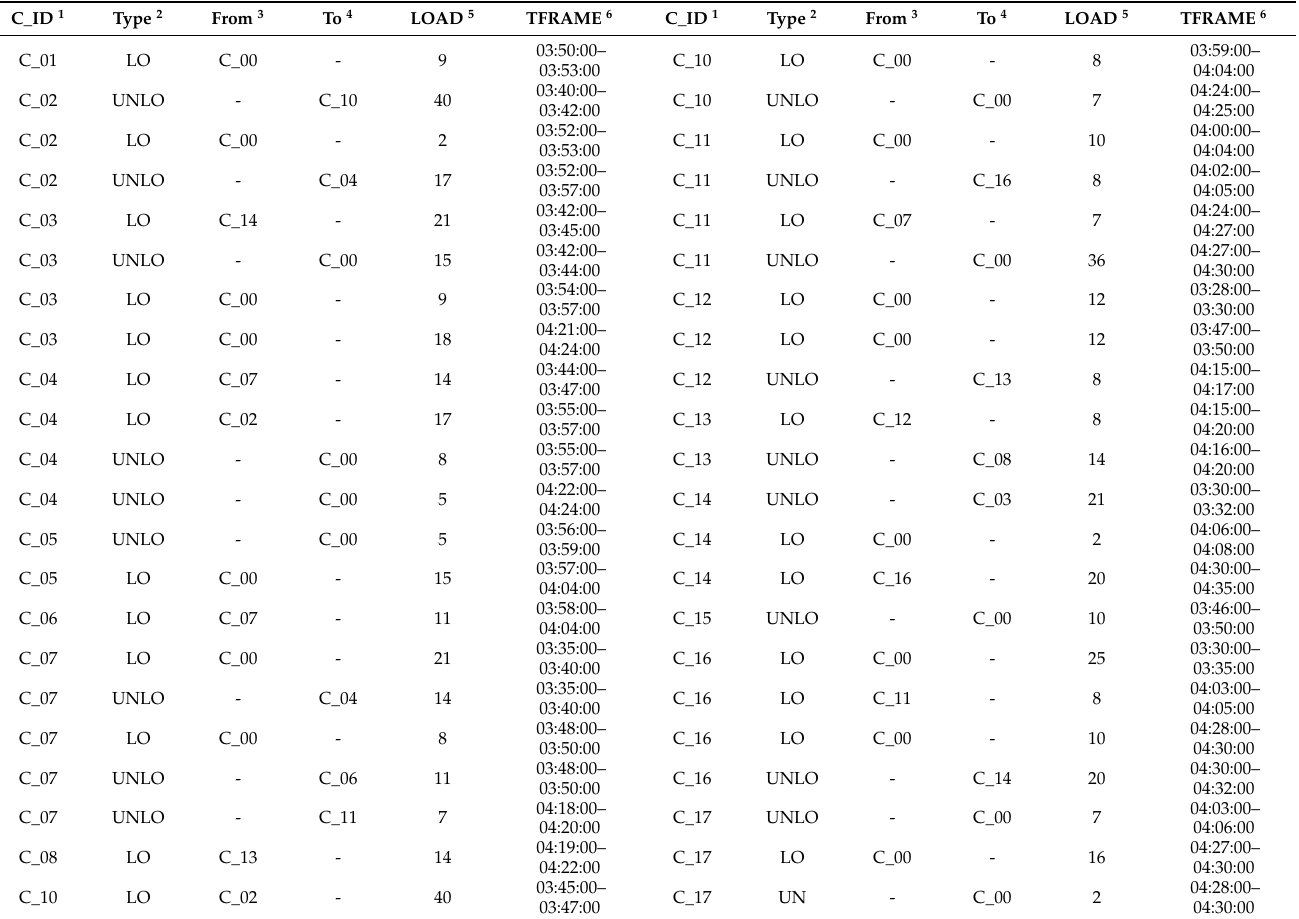
Table 1. MES data-based supply demands of the in-plant supply optimization problem.